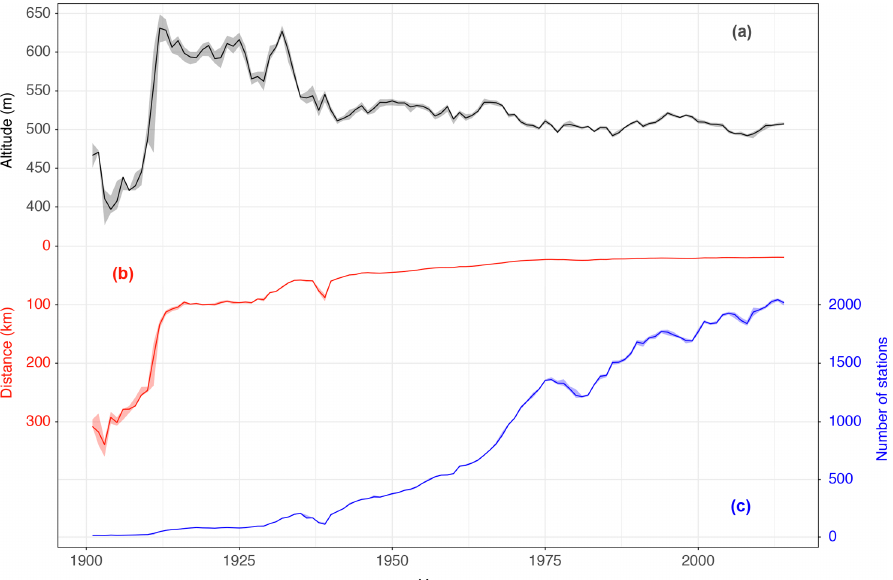
Figure 2. Median altitude of the stations by year ( a , black), median distance between stations ( b , red) and median number of stations per year ( c , blue). Coloured shadings indicate intervals between 25th and 75th